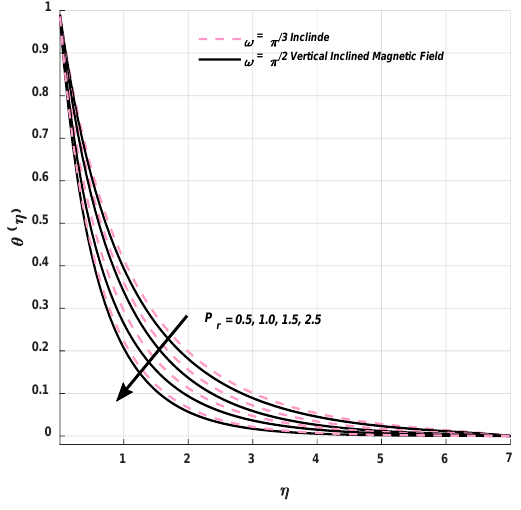
on . on . on . 𝜀𝜀 𝛾𝛾(𝛾𝛾) 𝜀𝜀 𝛾𝛾(𝛾𝛾) 𝜀𝜀 𝛾𝛾(𝛾𝛾)